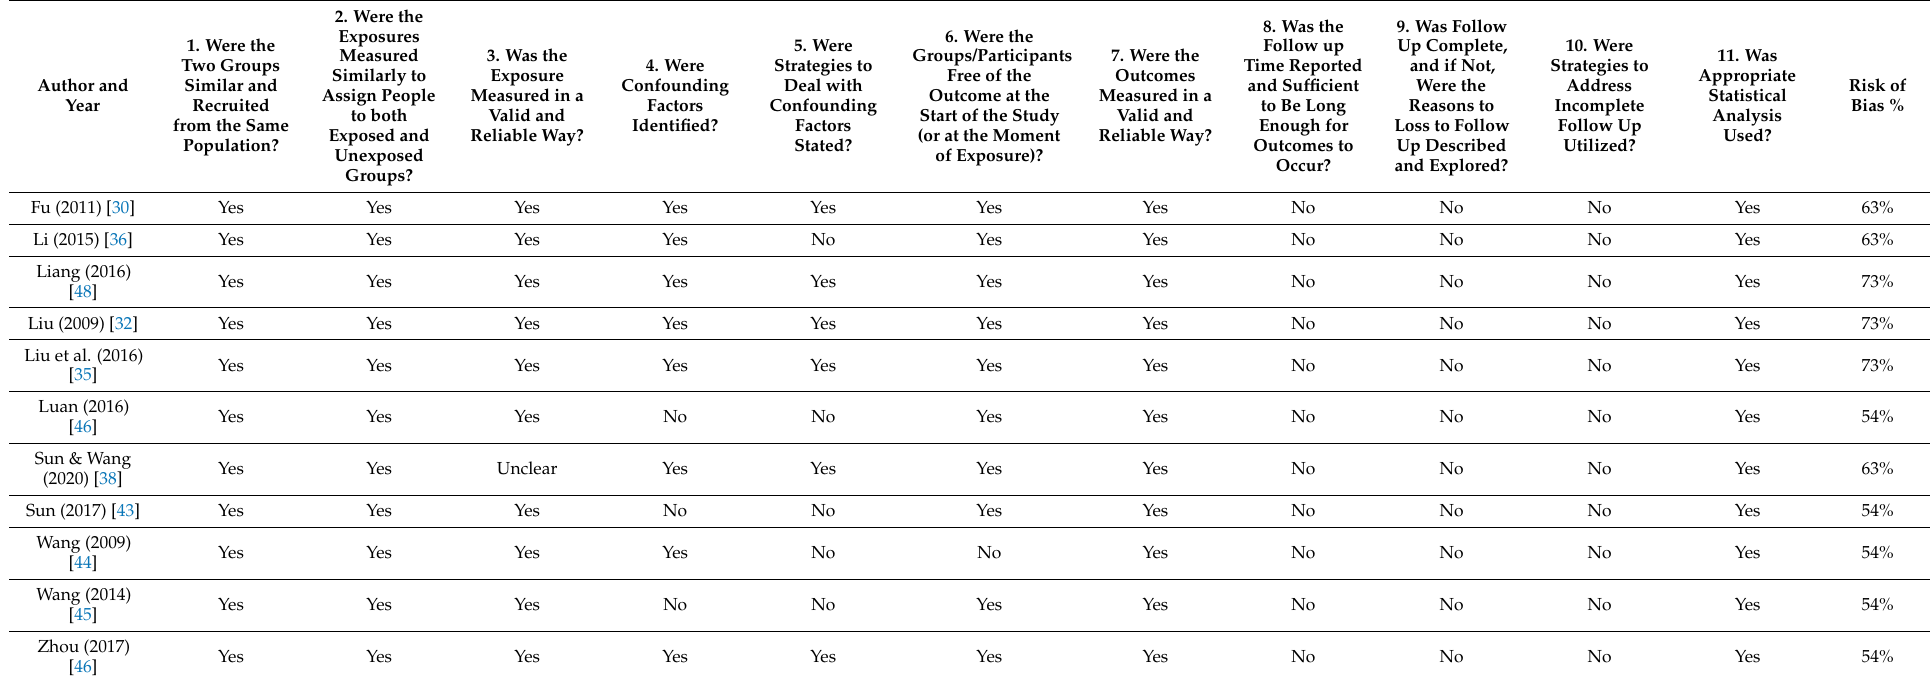
Table 4. The Quality Assessment of Cohort